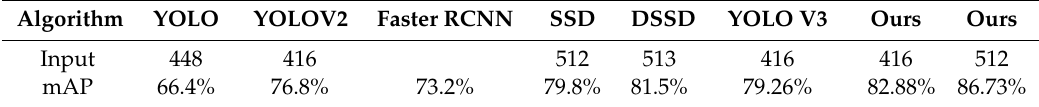
Table 5. Results of the state-of-the-art algorithms in PASCAL VOC data.